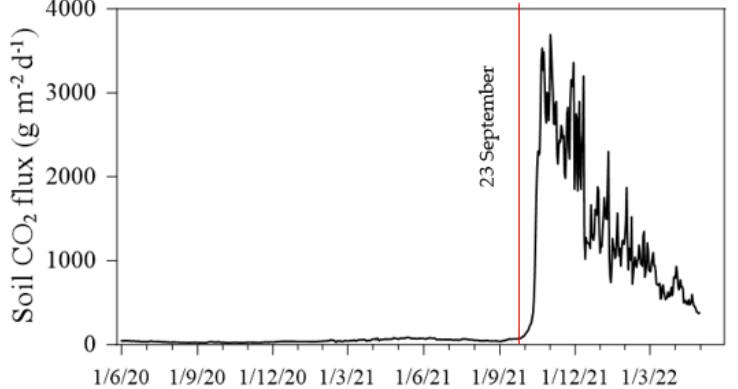
Figure 11. Data of soil CO 2 flux recorded with hourly frequency at Rimessa.